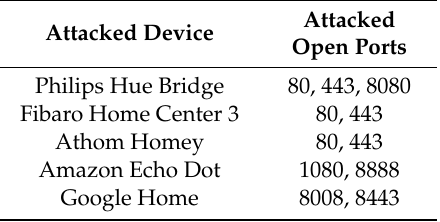
Table 2. Destination ports for DDoS